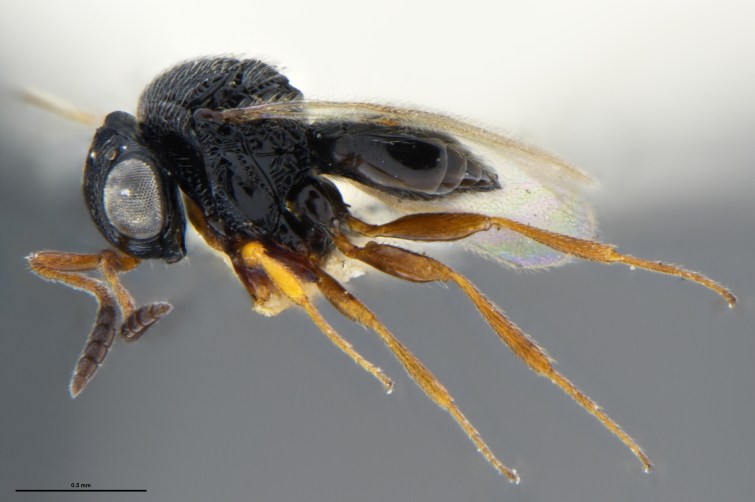
lateral habitus